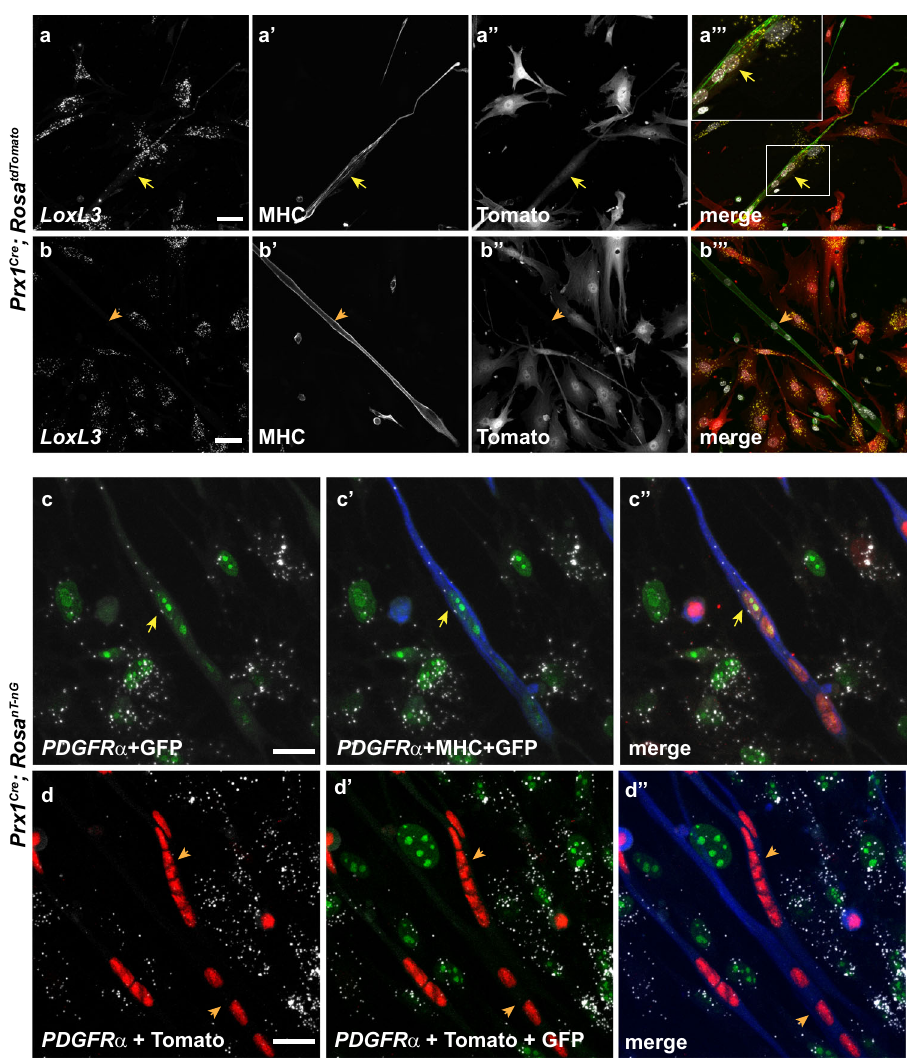
Fig. 4 Fused LPM-derived cells actively transcribe and contribute fi broblast-associated genes to growing myotubes. FISH for LoxL3 ( a – b ″′ ) or PDGFR α ( c – d ″ ) on primary cultured myoblasts and interstitial cells derived from Prx1 Cre ; Rosa tdTomato ( a , b ) or Prx1 Cre ; Rosa nt-ng ( c , d ) following 48 h of differentiation demonstrates that only in fi bers where LPM-derived cells have fused (yellow arrows) but not in tdTomato-negative ( b-b ″′ ) or GFP-negative ( d-d ″ ) are LoxL3 ( a ) or PDGFR α ( c ) RNA are observed. MHC in gray or green ( a , b ) or blue ( c , d ). Shown are representative images of FISH and immunostaining results of at least three independent cell isolation experiments from the distinct genotypes. Scale bar = 50 µ